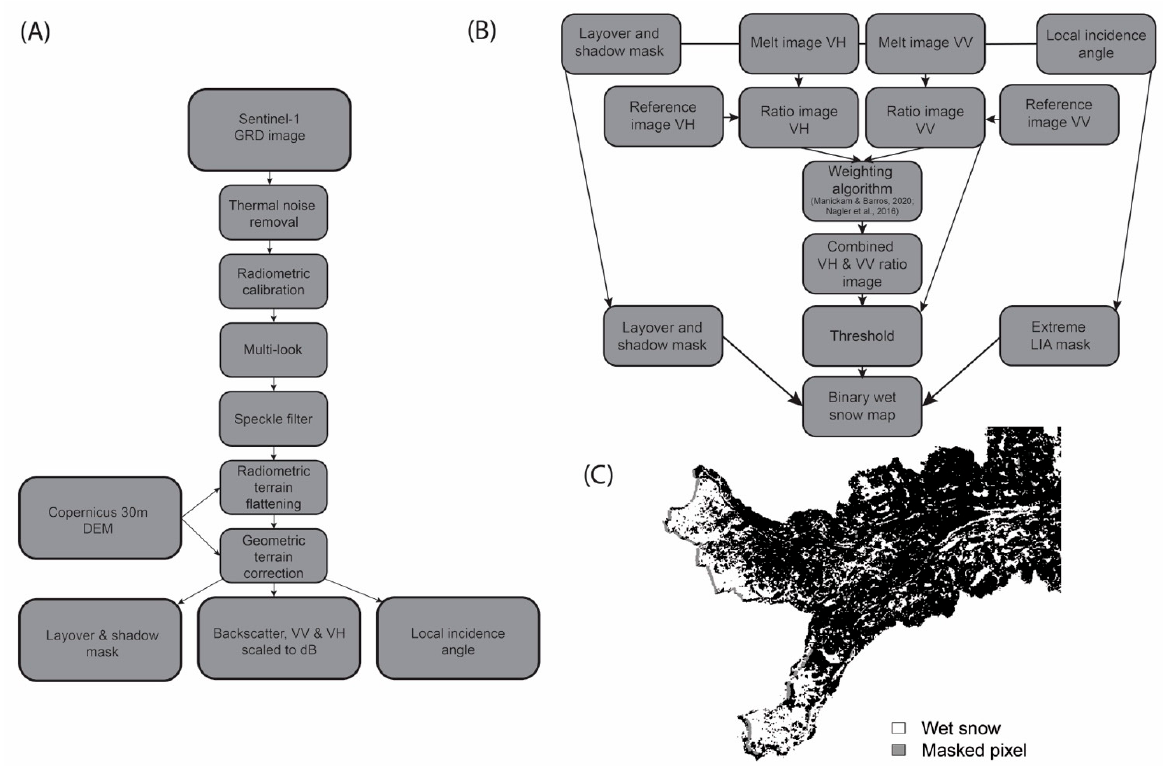
Figure 2. ( A ) Sentinel-1 processing steps, performed in the European Space Agency’s SNAP open- source software; ( B ) Backscatter image threshold wet snow identification process, accomplished in R [62]; ( C ) Example binary wet snow map.